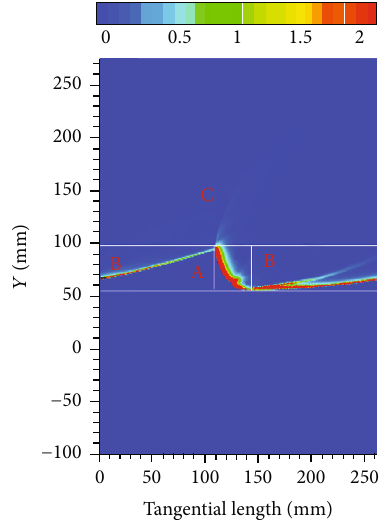
Figure 14: The division of the burning